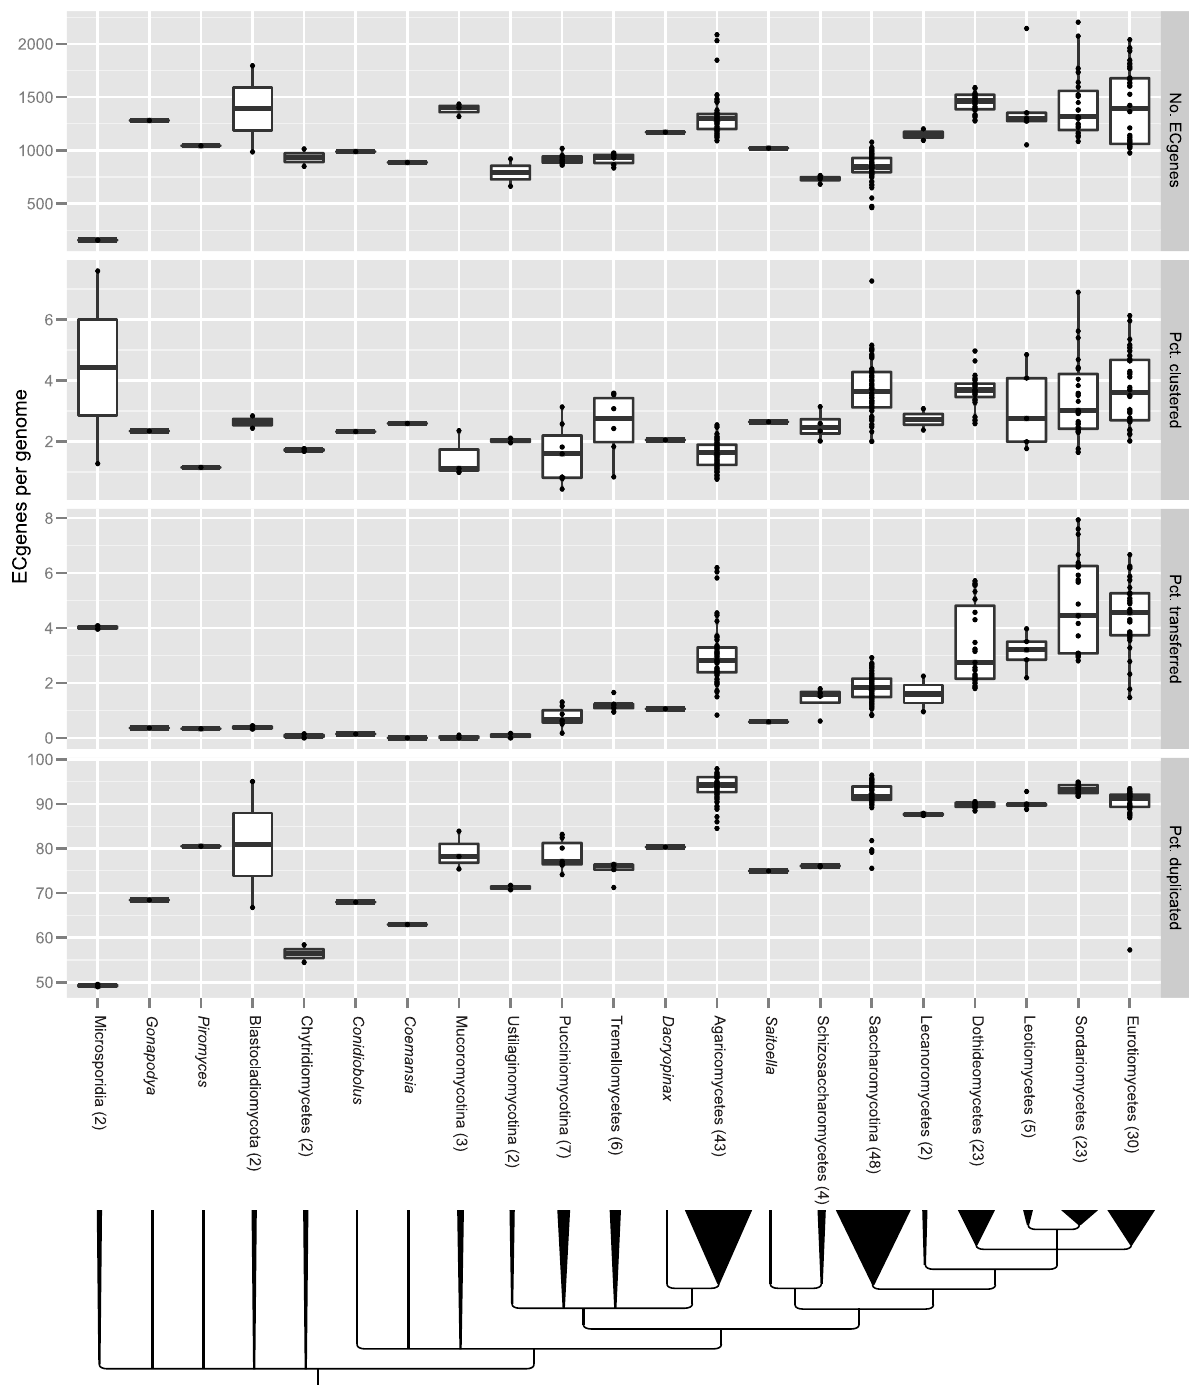
Figure 1. Variation in gene clustering, GD, and HGT across the fungal phylogeny. From top to bottom, the four box-and-whisker plots correspond to number of ECgenes per genome, percentage of clustered ECgenes per genome, percentage of horizontally transferred ECgenes per genome, and percentage of duplicated ECgenes per genome. The bottom and top of each box first and third quartiles (the 25th and 75th percentiles), respectively. The lower whisker extends from the box bottom to the lowest value within 1.5 * IQR (Inter-Quartile Range, defined as the distance between the first and third quartiles) of the first quartile. The upper whisker extends from the box top to the highest value that is within 1.5 * IQR of the third quartile. Data beyond the end of the whiskers are outliers and plotted as points. Numbers in parentheses after the lineages’ names indicate numbers of genomes in each lineage; the numbers of genomes used from each lineage are also reflected by the widths of their branch triangles on the fungal species phylogeny shown at the bottom of the figure.